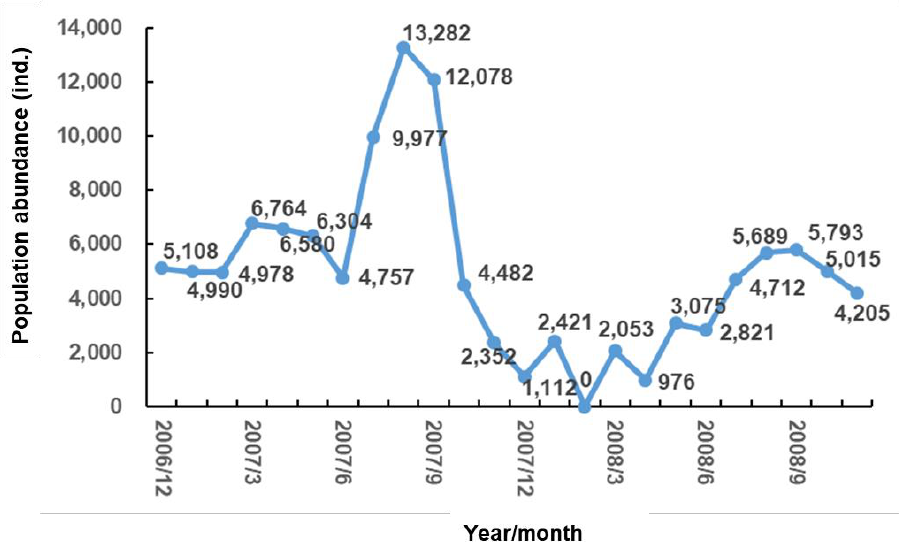
Figure 8. Fluctuations in number of crab species, Uca formosensis , from December 2006 to November 2008 [39]. Note: This figure cites from Ecological Restoration in Kaya Water Recycling Center, Hsinchu City Habitat Improvement Restoration (Sub-project 2-1: Research on Uca formosensis and Its Habitat).